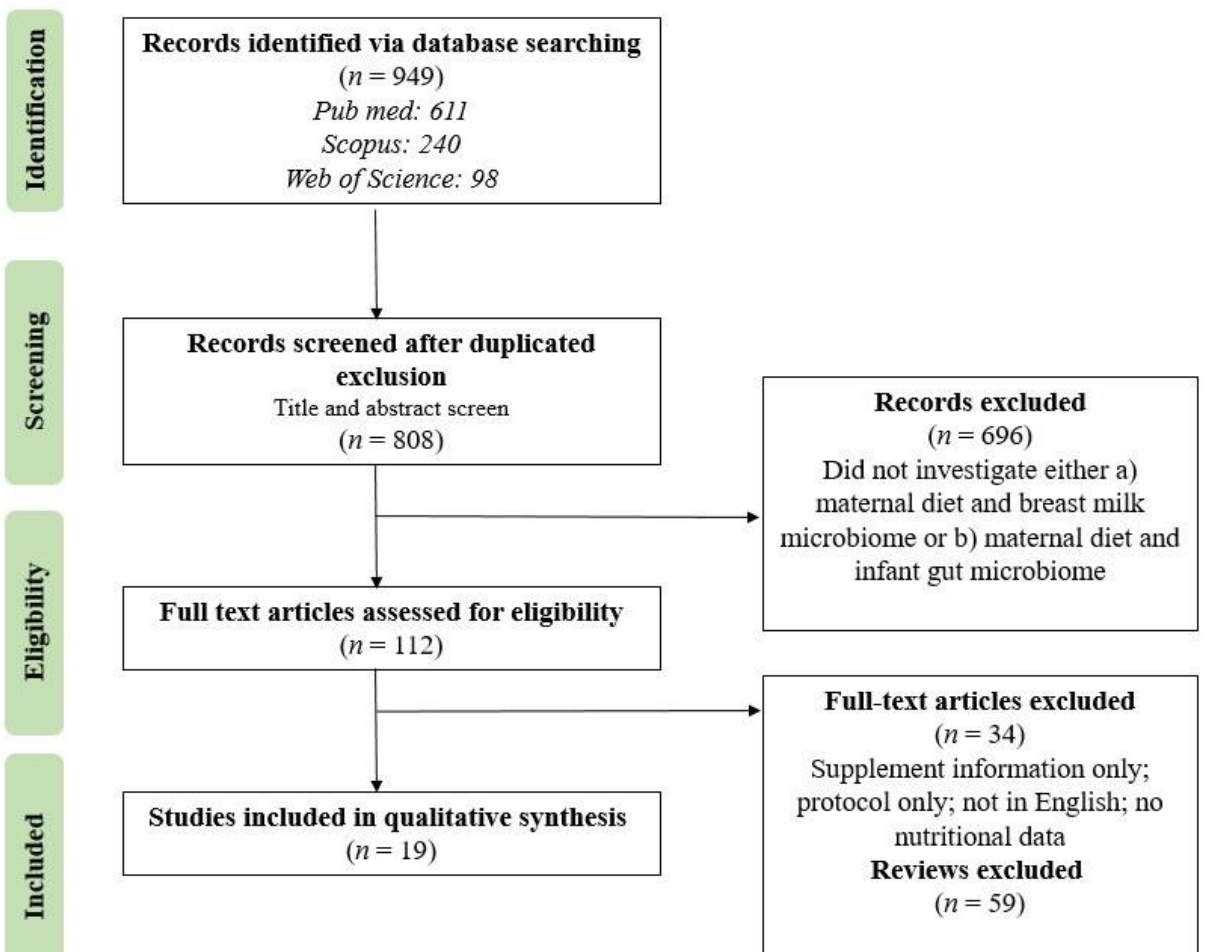
Figure 1. Flow diagram describing study selection process.